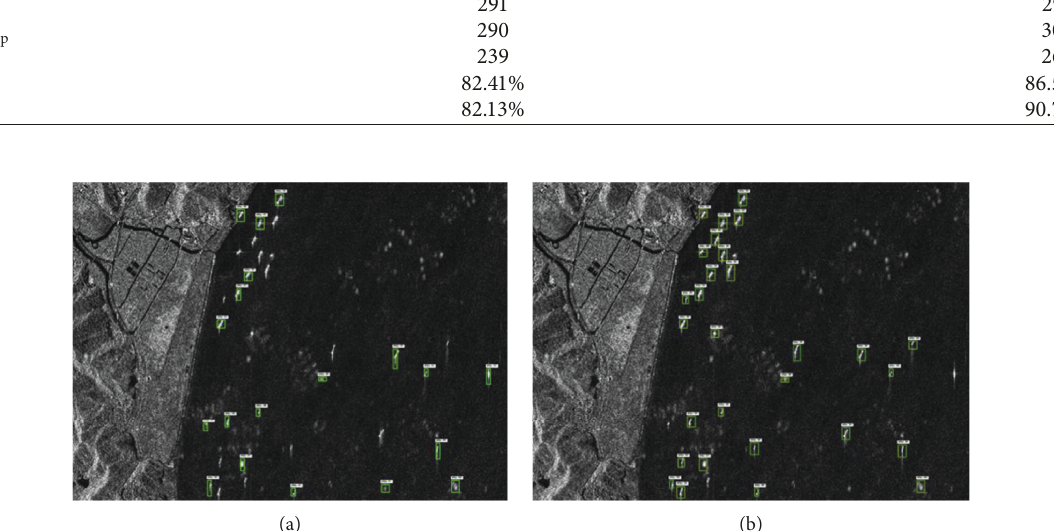
Figure 19: The detection results of different methods on the large-scene image I. (a) The original Faster RCNN method. (b) The proposed detection method.